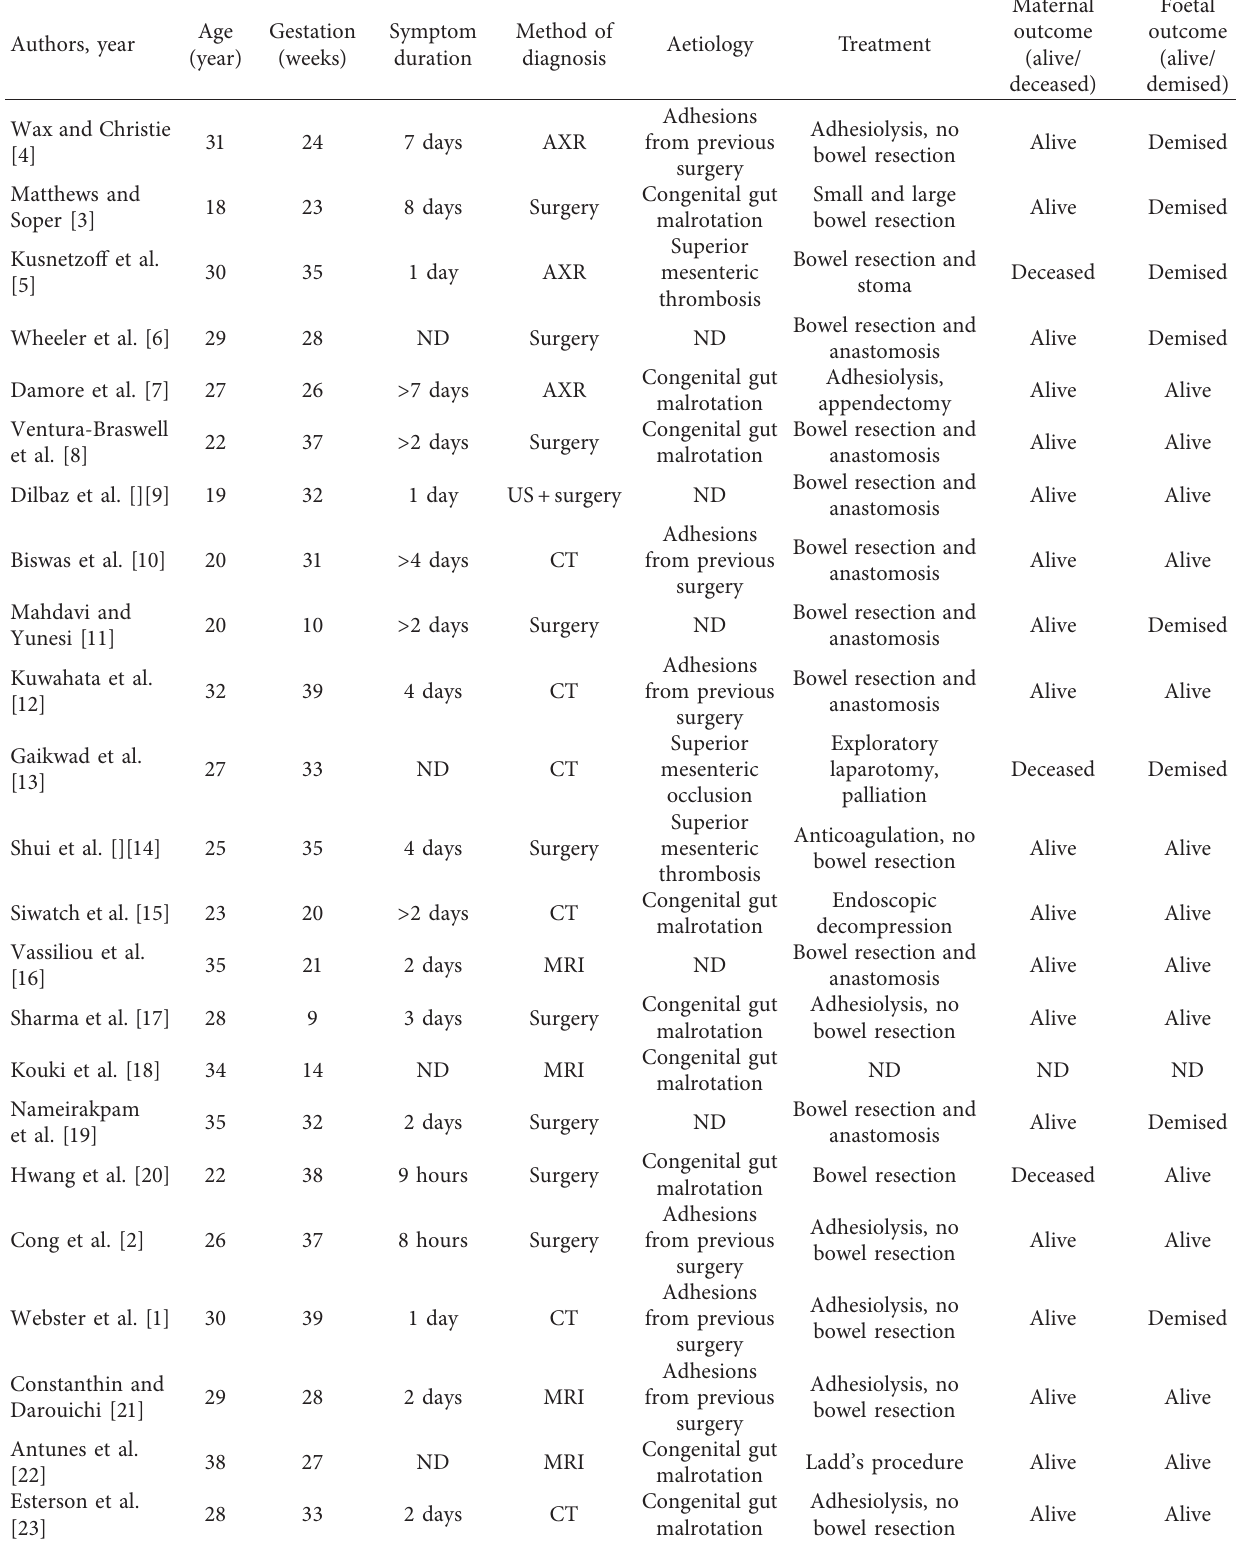
Table 1: Cases of midgut volvulus in pregnancy (excluding puerperium) from